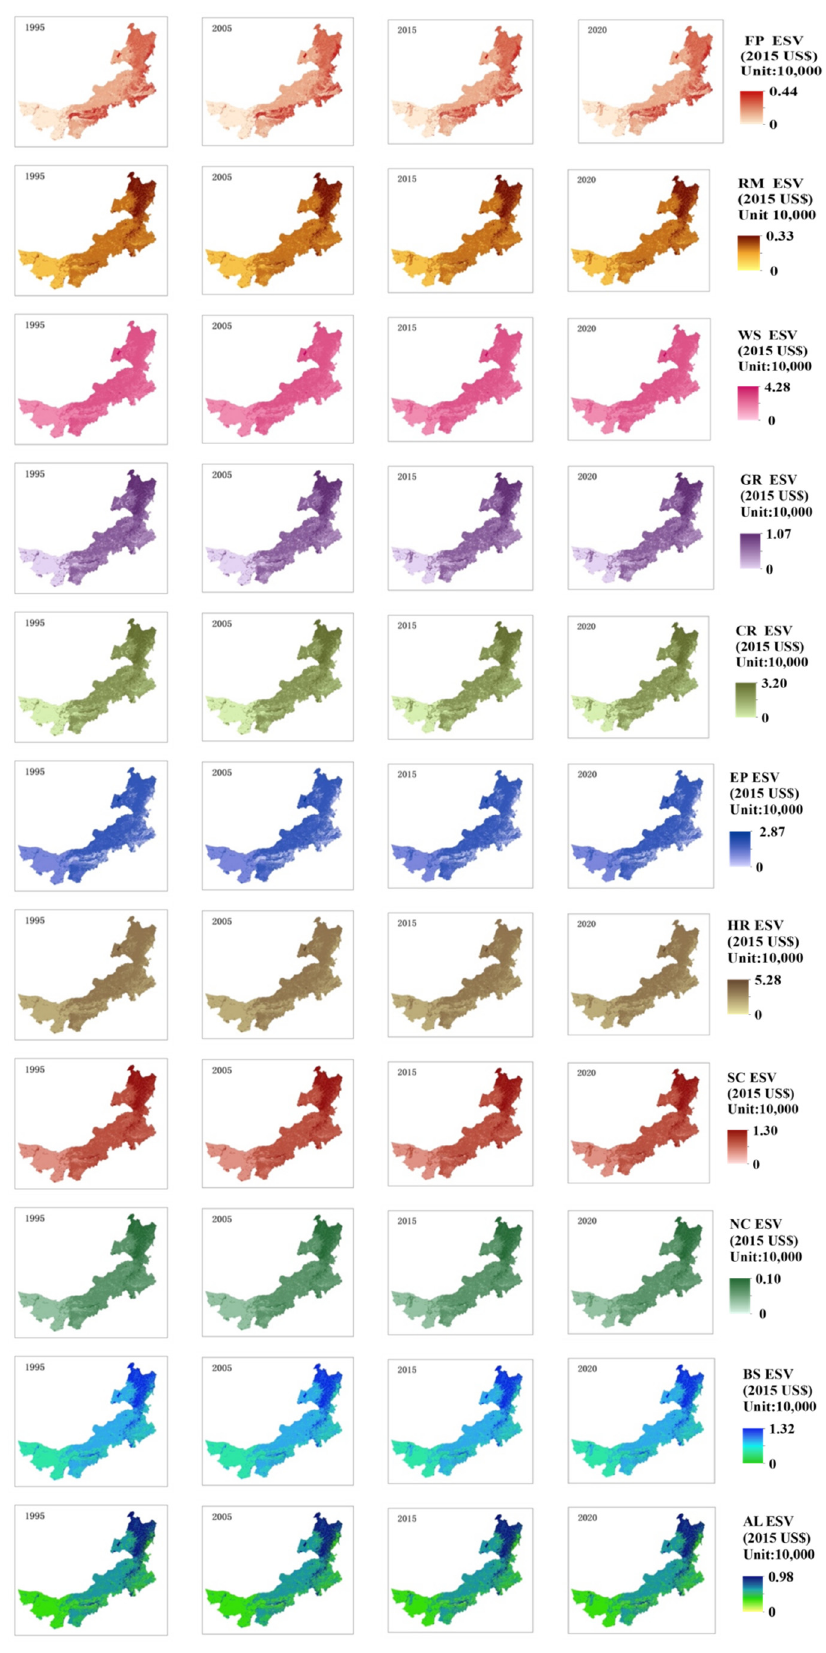
Figure 3. Spatial pattern of individual ESV in Inner Mongolia from 1995 to 2020.